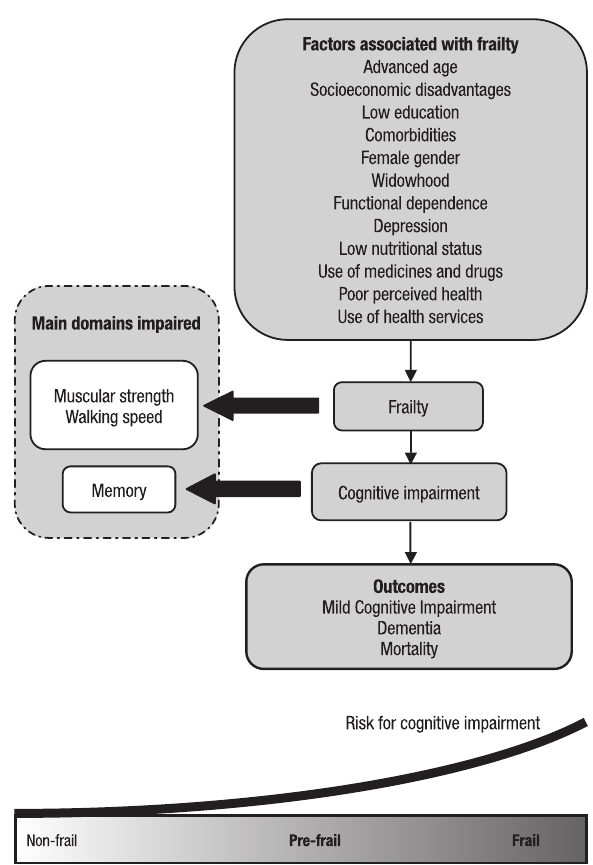
Figure 2. Model of association between factors, frailty, cognitive impair- ment and their outcomes in older